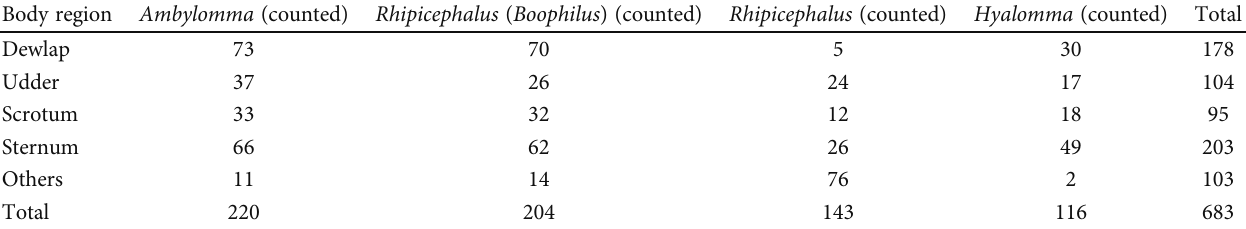
Table 3: Genera of ixodid ticks and their distribution on body regions of cattle in the Areka District. Body